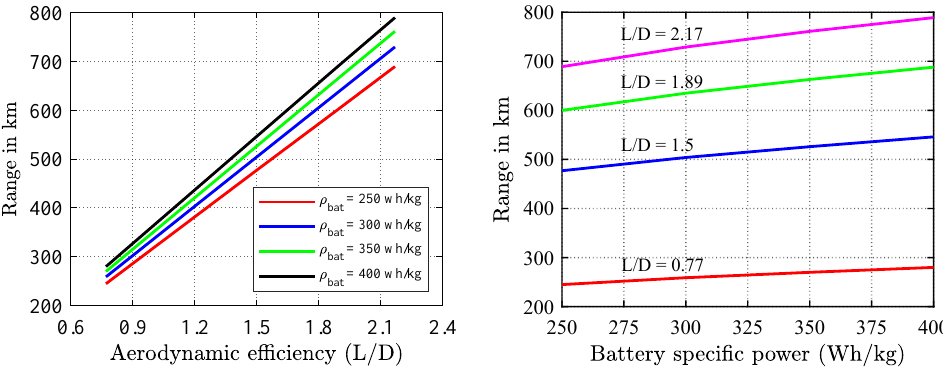
Figure 8. Effect of aerodynamic efficiency and battery specific power on range